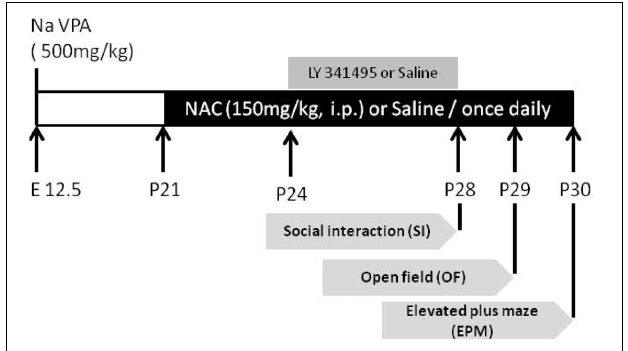
FIGURE 1 | The experimental design employed in the present study. On postnatal day 21 (P21), NAC (150mg/kg, intraperitoneal (i.p.); sigma) or saline was administered once daily for 10 days. From P28 to P30, the social interaction test, elevated plus-maze test, and open field test were conducted each day after NAC treatment. To elucidate whether the effect of NAC on social interaction in VPA-exposed offspring is mediated by mGluR2/3, on P24, the mGluR2/3 antagonist LY341495 (2 µ g/0.5 µ l/side) was infused into the amygdala 30min before the administration of NAC once per day for 5